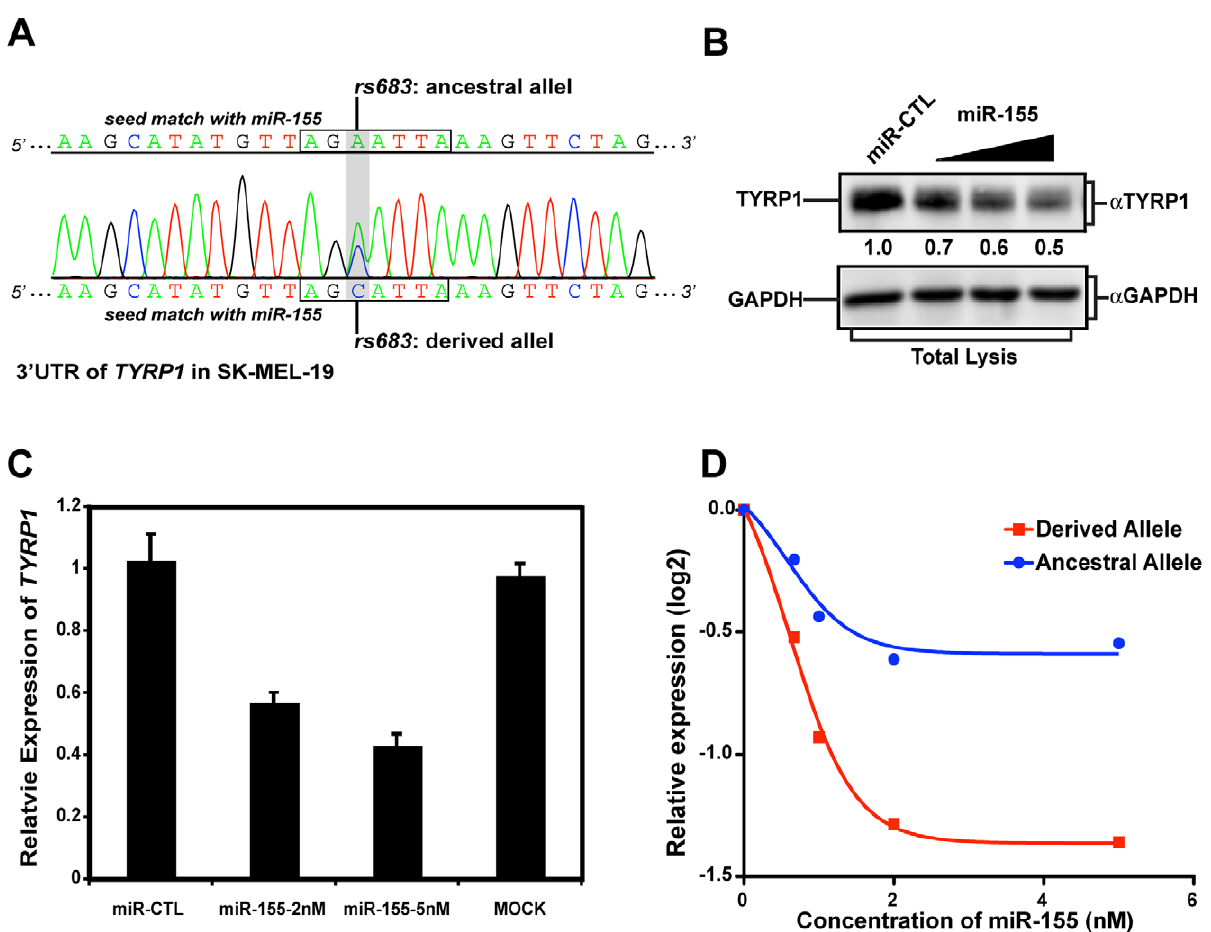
Figure 3. rs683 modulates endogenous TYRP1 targeting by miR-155 in SK-MEL-19 cells. (A) Genotyping the rs683 locus in SK-MEL-19 cells. The region around rs683 was amplified from SK-MEL-19 genomic DNA and sequenced. Sequence traces (shown) revealed rs683 heterozygosity at the TYRP1 locus, as indicated. (B) Ectopic miR-155 expression reduces TYRP1 protein levels. TYRP1 levels in the skin-derived melanoma cell line, SK-Mel-19 were analyzed by performing immunoblotting on cell lysates from miR-CTL transfected or cells transfected with increasing amounts of miR-155 as indicated. Densitometric quantitation of TYRP1 levels is indicated as protein levels relative to the mock transfectants. (C) miR-155 reduces TYRP1 mRNA levels in SK-Mel19. SK-MEL19 cells were mock transfected or transfected with the indicated miR-CTL or miR-155. mRNA was extracted and TYRP1 levels assessed by qPCR. Results are plotted relative to miR-CTL-treated cells. Bars are the mean 6 standard deviation of triplicate experiments. The differences in expression between miR-155 transfected cells and either mock or miR-CTL are statistically significant (P , 0.01, Students t test). (D) Targeting of the derived allele by miR-155. SK-Mel-19 cells were transfected with increasing amounts of miR-155 as indicated. mRNA was then extracted and expression of the ancestral (blue) versus the derived allele (red) assessed by allele-specific TaqMan SNP qPCR. Results are plotted as the expression level of each TYRP1 allele relative to controls (log2 transformed). Note that the transcripts carrying the derived allele were suppressed by miR-155 greater that 2-fold, whereas transcripts carrying the ancestral allele were only modestly